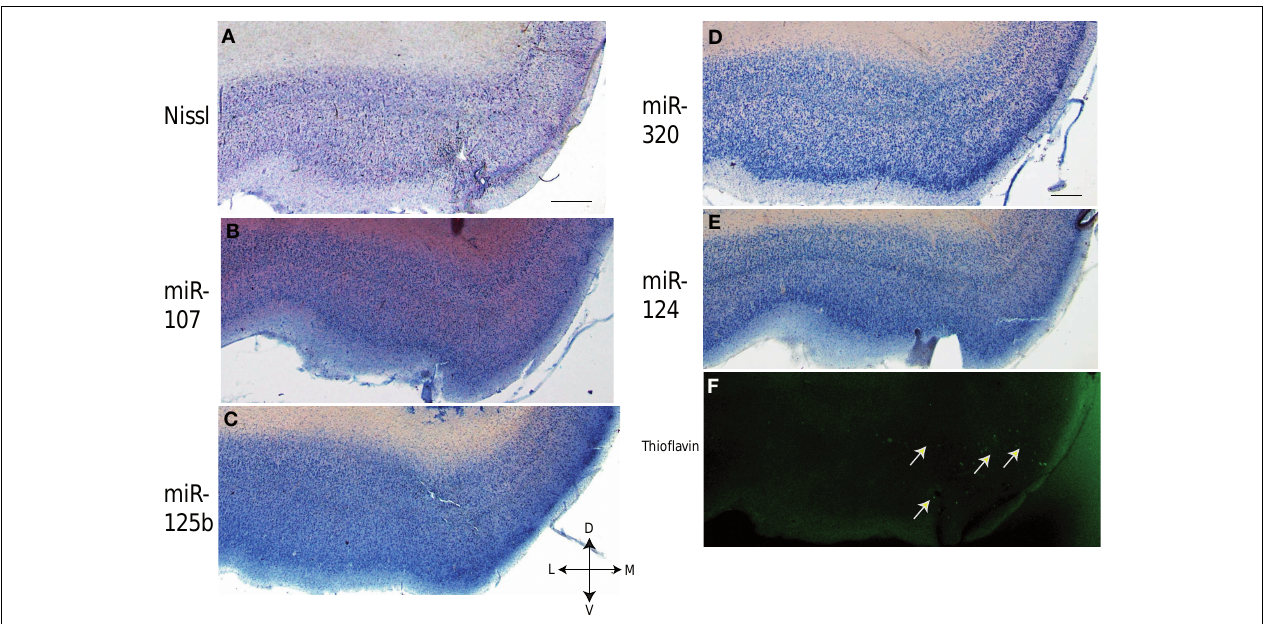
fl uorescent.) In this case, there were no amyloid plaques and a few scattered neurofi brillary tangles, which are indicated with arrows in the transentorhinal